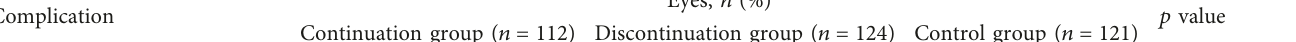
Table 4: Incidence of complications by group.